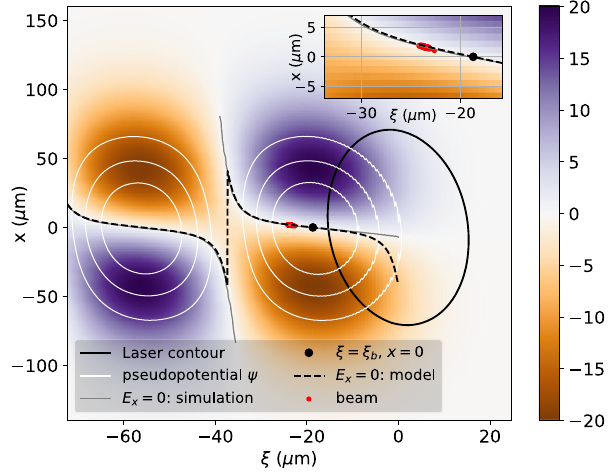
FIG. 1. Transverse electric field (GV/m) in a 2D LPA simu- lation with a τ ¼ 60 fs, w 0 ¼ 70 μ m y -polarized laser pulse with a 0 ¼ 0 . 1 propagating in a plasma with density 2 × 10 17 cm − 3 . The PFT angle ψ ≃ 30 mrad at the snapshot location is due to ¼ 500 fs 2 , and ζ ¼ 0 . 5 mm fs at focus, resulting in an β ¼ 0 , φ 2 8.5% intensity drop. The black solid-line ellipse is an isocontour of 1 = 4 laser intensity. A short electron beam (red) is at equilibrium off axis, as can be seen in the enlargement k w tan ψ ≪ 1 . In the linear regime, the pseudopotential Ψ , p defined by Ψ ¼ ϕ − a with ϕ the normalized electrostatic z potential and a the longitudinal vector potential, can be z obtained through integration along the ξ coordinate only behind the laser, where Ψ 0 depends on the pulse intensity and shape. This equation shows that the plasma phase delay equals the laser group delay for any x in the quasistatic linear ¼ e ∂ Ψ = ∂ x ¼ 0 , is regime. The wake line, defined by F x given by 4 x tan ψ þ This expression was used to plot the dashed line in Fig. 1, which shows excellent agreement with the simulation (gray line). As this equation cannot be solved analytically to get x ¼ f ð ξ Þ , we propose a simplified model. A Taylor expan- ¼ − ð π = 2 Þ k − 1 sion close to the center of the first bucket ξ b p (where the wake line intersects the z axis, black dot in Fig. 1)